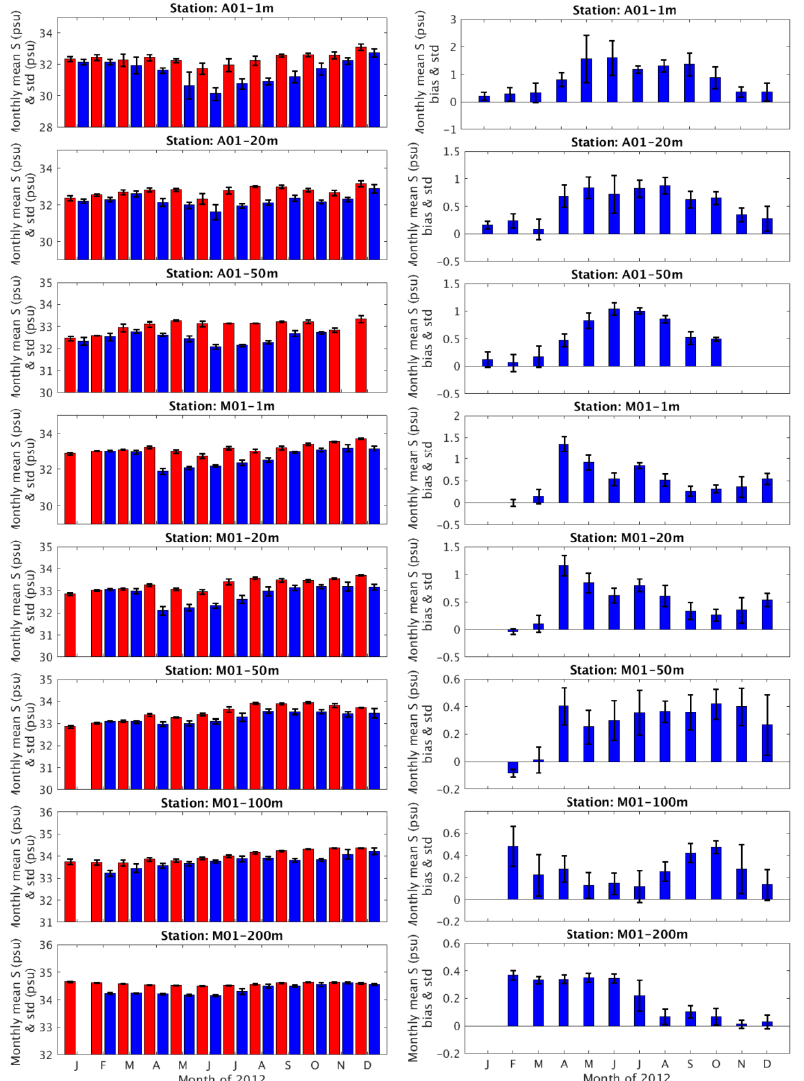
Figure 7. ( Left panel ) Comparison of the monthly averaged salinity between the model (red bars) and the observations (blue bars) at the NeraCOOS buoys A01 and M01. The station name and the measurement depths are as shown on each plot. On some plots the observations do not appear due to the lack of data. ( Right panel ) Bias of the modeled monthly mean temperature. The black lines on top each bar represent the corresponding standard deviations.